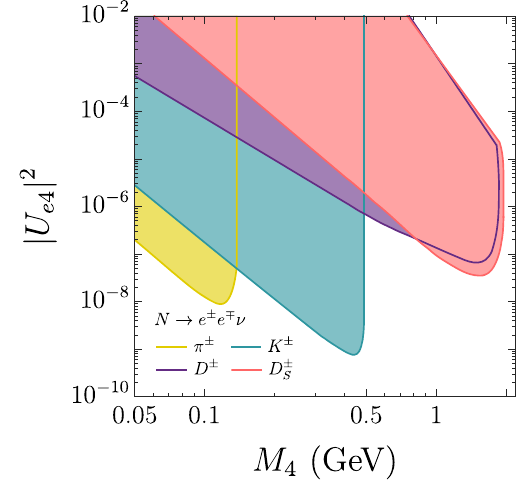
Fig. 5 90% CL contour for the expected sensitivity to the mixing | U | 2 as a function of the heavy neutrino mass for a total amount of e 4 7 . 7 × 10 21 PoT. The different regions show the contributions obtained whentheheavyneutrinosareproducedfromthedecaysofagivenparent meson, as indicated by the